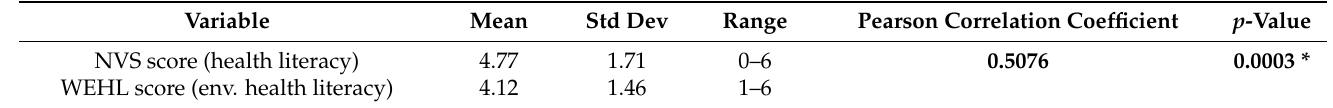
Table 1. NVS and WEHL scores ( n = 47).